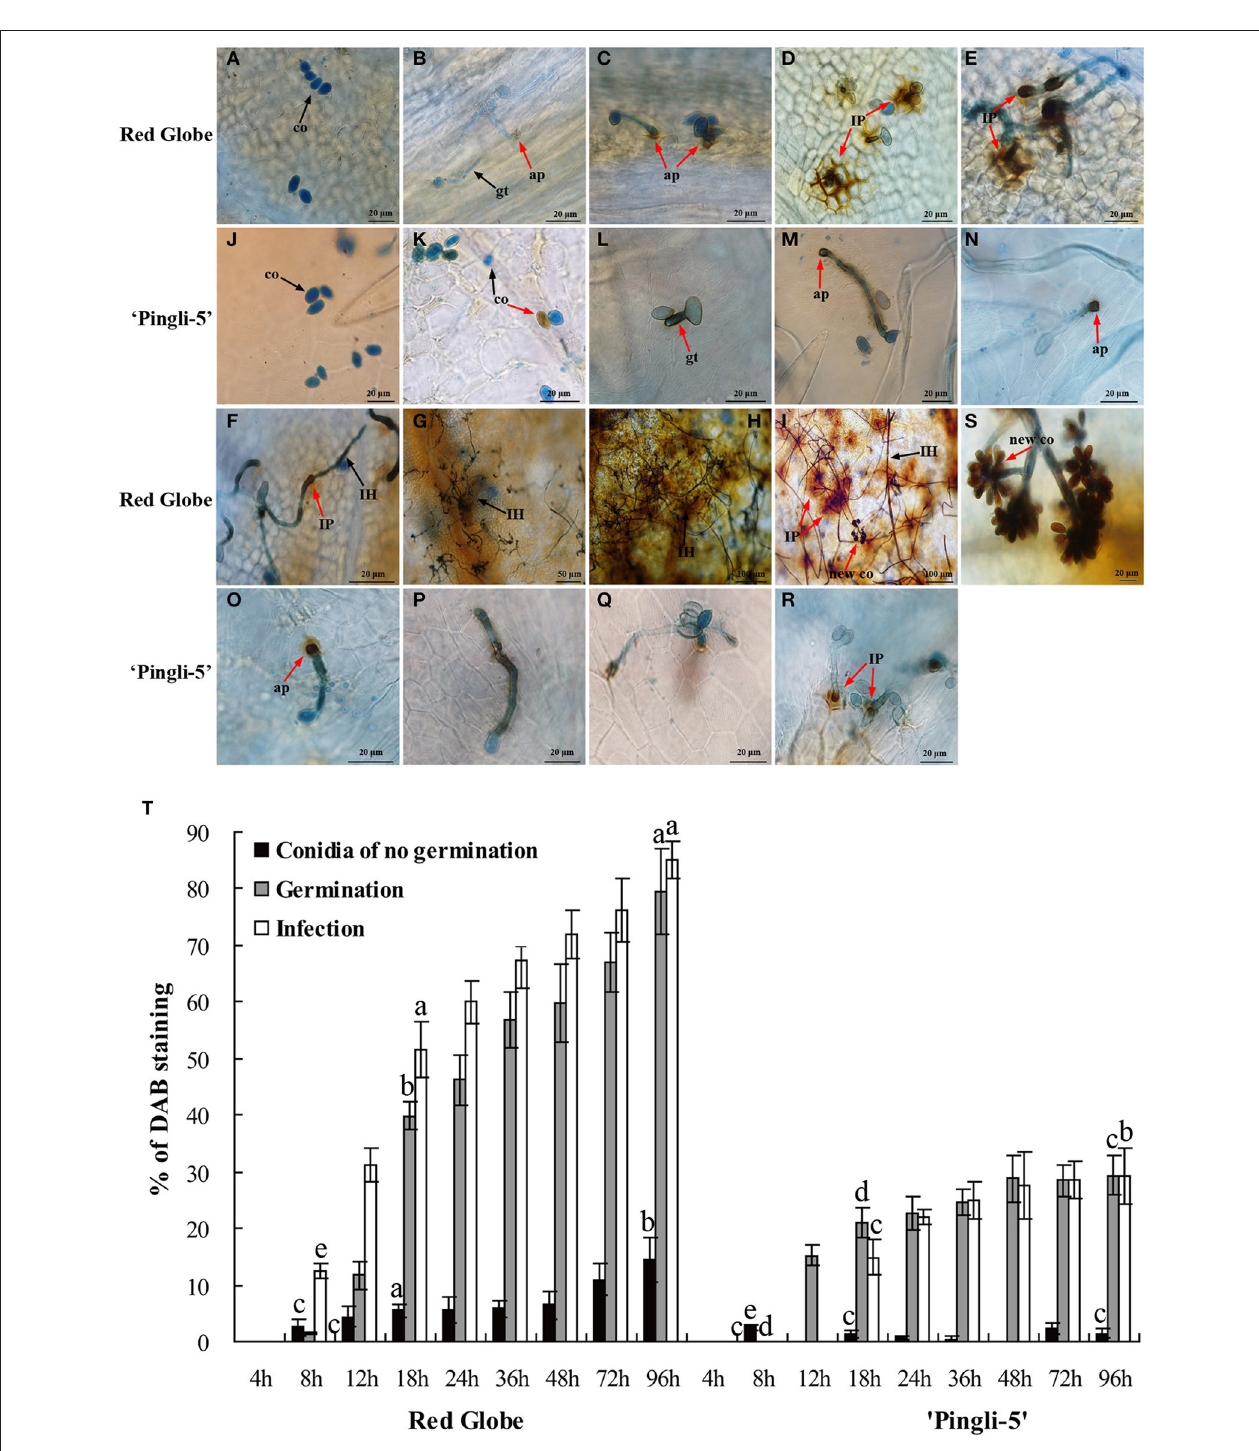
FIGURE 5 | Temporal evolution of H 2 O 2 accumulation in the leaves of “Red Globe” and “Pingli-5” as well as in B. cinerea following inoculation. Aniline blue stains the fungus a bluish color while DAB (3-diaminobenzidine) stains H 2 O 2 purple. H 2 O 2 accumulation was assessed in the interactions of “Red Globe” (A–I) and “Pingli-5” (J–R) with B. cinerea 4, 8, 12, 18, 24, 36, 48, 72, and 96h post-inoculation (hpi). Arrows indicate a co, conidium; gt, germ tube; ap, appressorium; IP, infection peg; IH, infection hypha; and new co, new conidium. Black arrows indicate no DAB staining and red arrows indicate DAB staining. (S) Higher magnification of the site of the red arrow in (I) , showing the DAB stained sporulation. Scale bars: (A–F) : 20 µ m; (G) : 50 µ m; (H,I) : 100 µ m; (J–R) : 20 µ m; (S) : 5 µ m. (T) Percentages of B. cinerea conidia, germ tubes and infection sites exhibiting H 2 O 2 accumulation at the indicated times. At least 300 conidia were counted at each time point. Experiments were repeated three times with similar results. Bars represent standard deviations. Comparisons of statistical significance were made for the three indices. Different small alphabetical letters indicate statistically significant differences between different interactions of “Red Globe” and “Pingli-5” with B. cinerea at the indicated time points (Duncan’s multiple range test; P < 0.05)